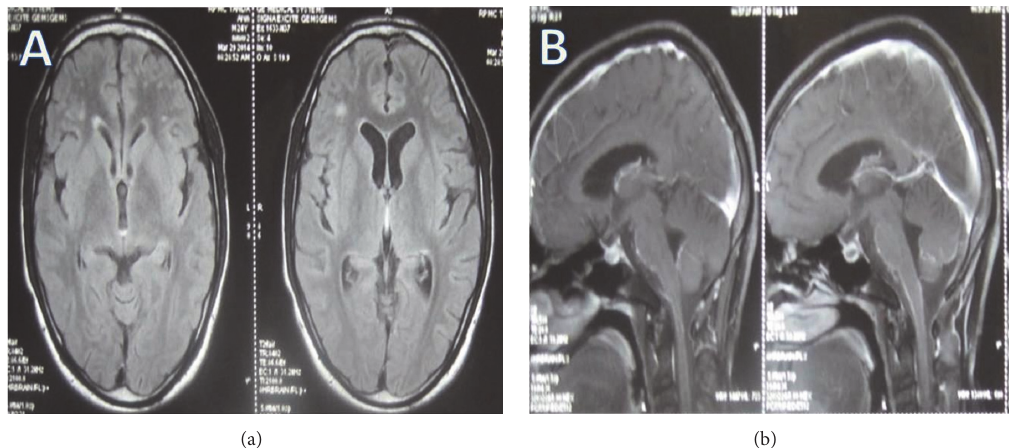
Figure 1: (a) Axial FLAIR images showing white matter periventricular and subcortical hyperintensities bilaterally. (b) After contrast brainstem meningeal enhancement is